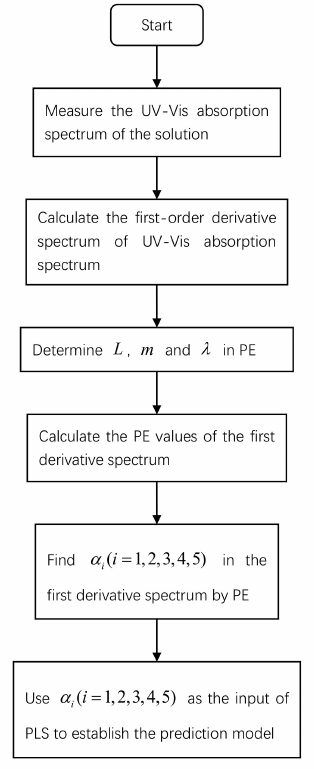
Figure 5. The flow chart of